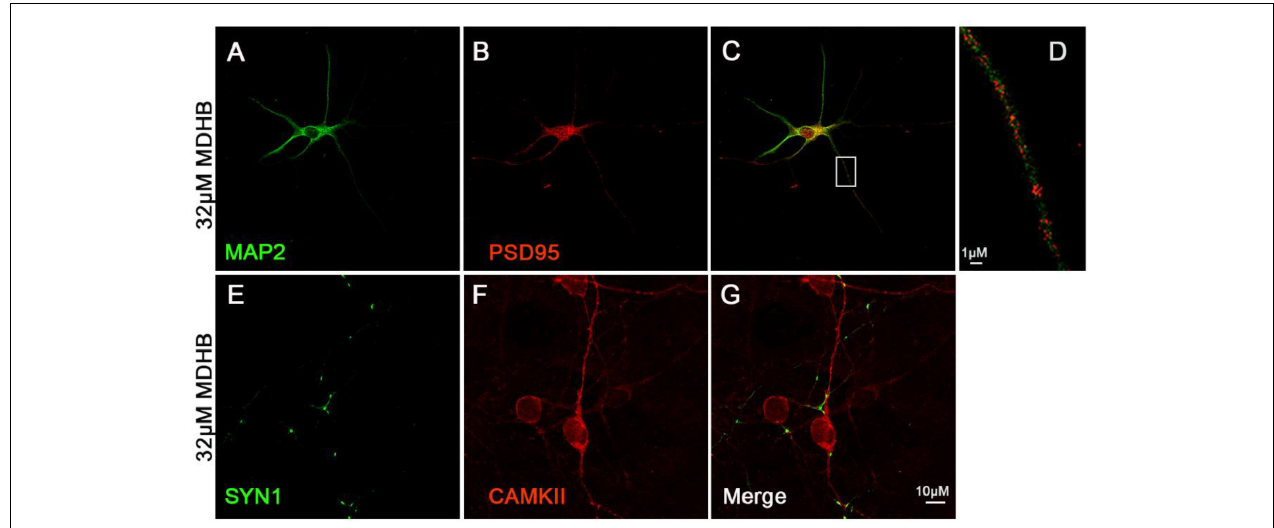
FIGURE 5 | The expression of synaptic protein in MDHB –induced neurons. (A–D) MDHB –induced neurons has the expression of postsynaptic dense protein (PSD95); (E–G) MDHB –induced neurons has the expression of Synapsin I